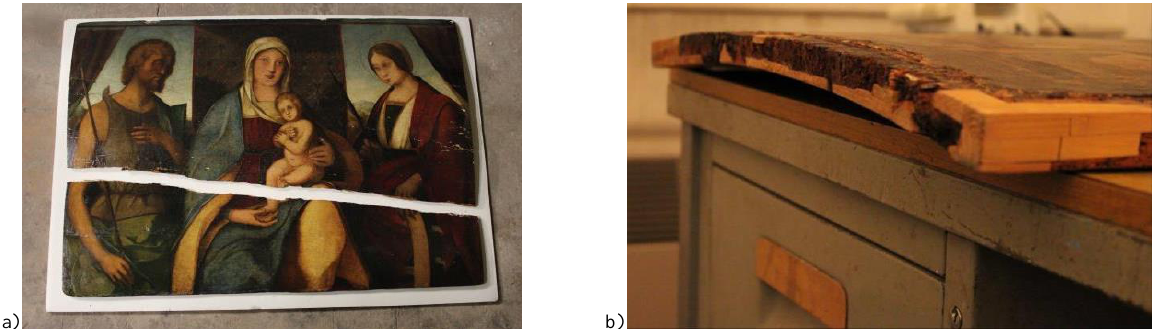
Figure 1. An example of a damaged painting (a). A Cretan icon showing a clear bending effect (b). Both paintings are located in the depots of the Soprintendenza per i Beni Storico Artistici ed Etnoantropologici of Bologna,